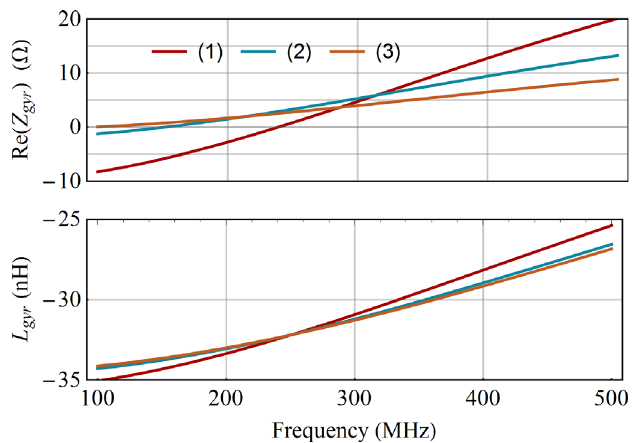
Fig. 10. Input impedance of the gyrator circuit, Z gyr = Re ( Z gyr )+ jL gyr v (1) g m =7 mS, C =0.87 pF, f Re0 = 239MHz